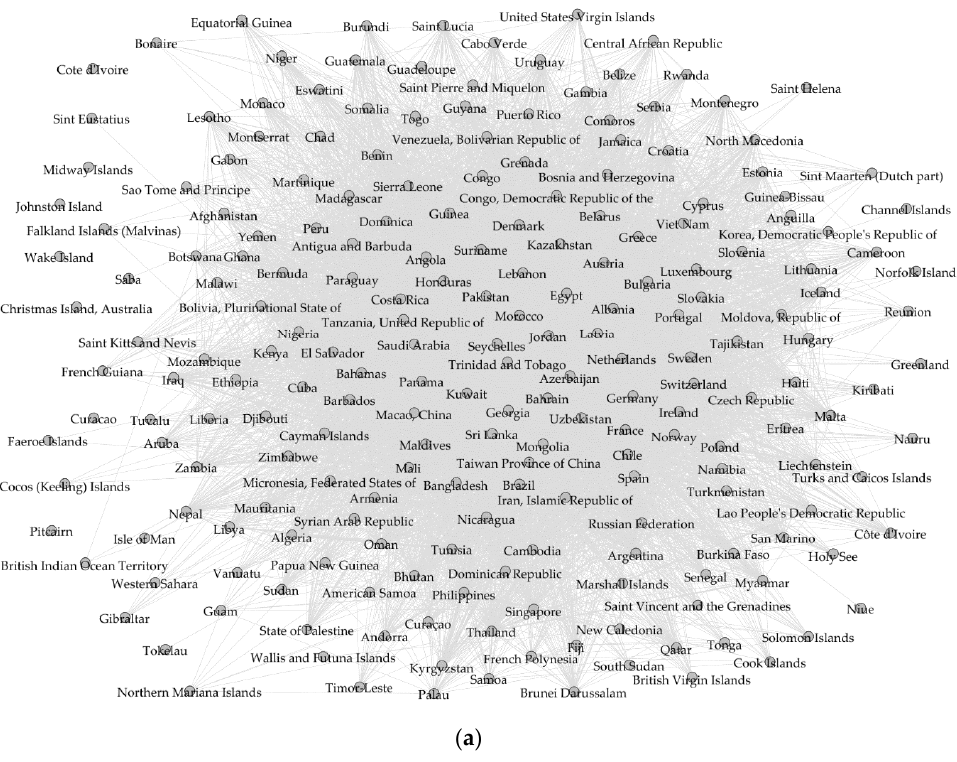
Figure A1. Simulation of arbitrary link removal. ( a ) Network after 10% randomly removed links of all possible links (or 34% of existing links), ( b ) network after 20% randomly removed links of all possible links (or 68% of existing links), and ( c ) network after 25% removed links of all possible links (or 83% of existing links). Source: authors.